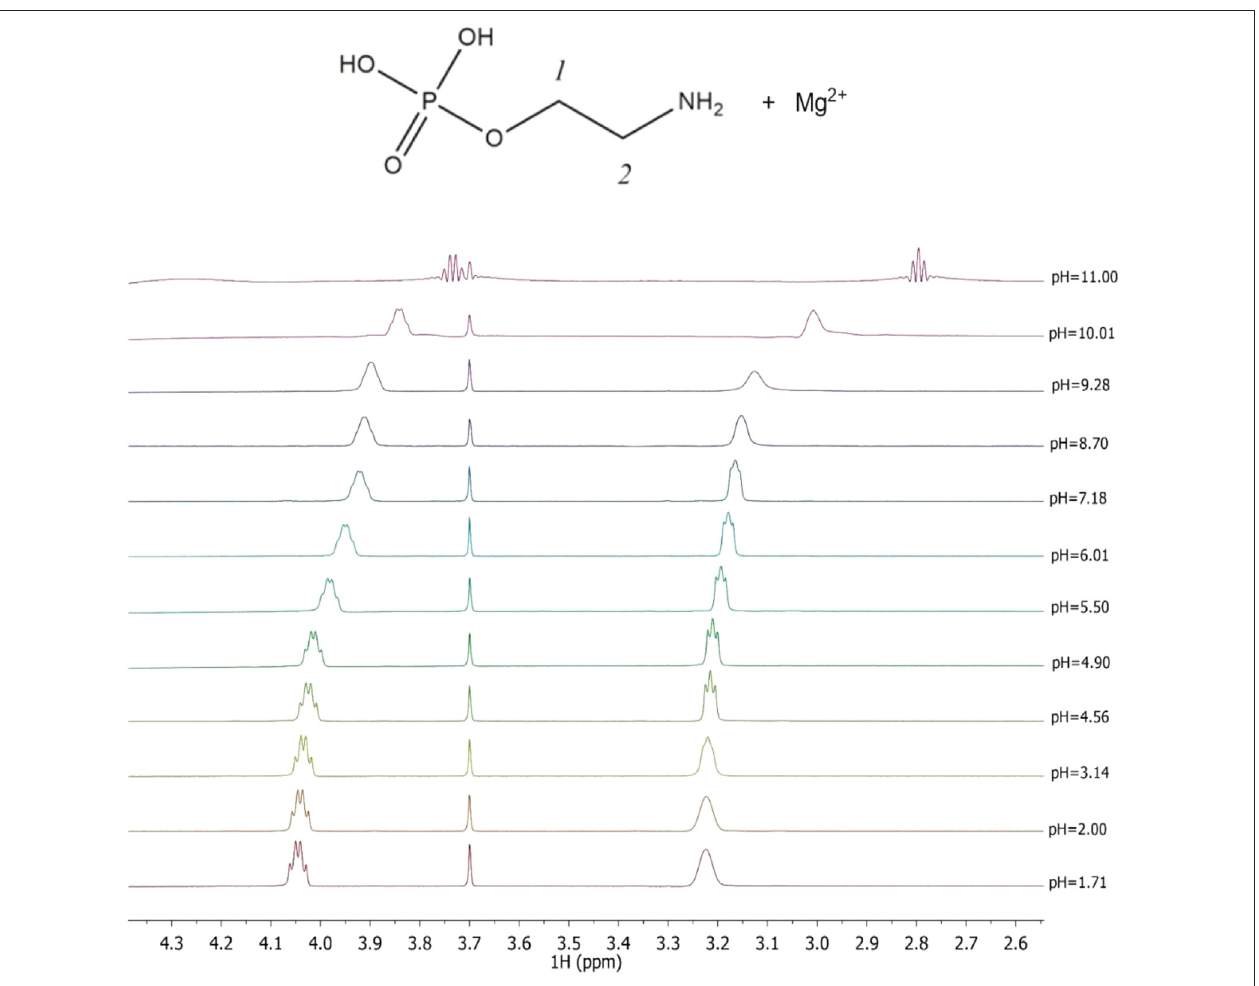
FIGURE 3 | Superimposed 1 H-NMR spectra of solutions containing Mg 2+ (M) e PEA (L) at C M = 6 mmol L − 1 , C L = 7 mmol L − 1 , t = 25 ° C, and I = 0.15 mol L − 1 in NaCl, range of pH = 1.71 – 11.00.